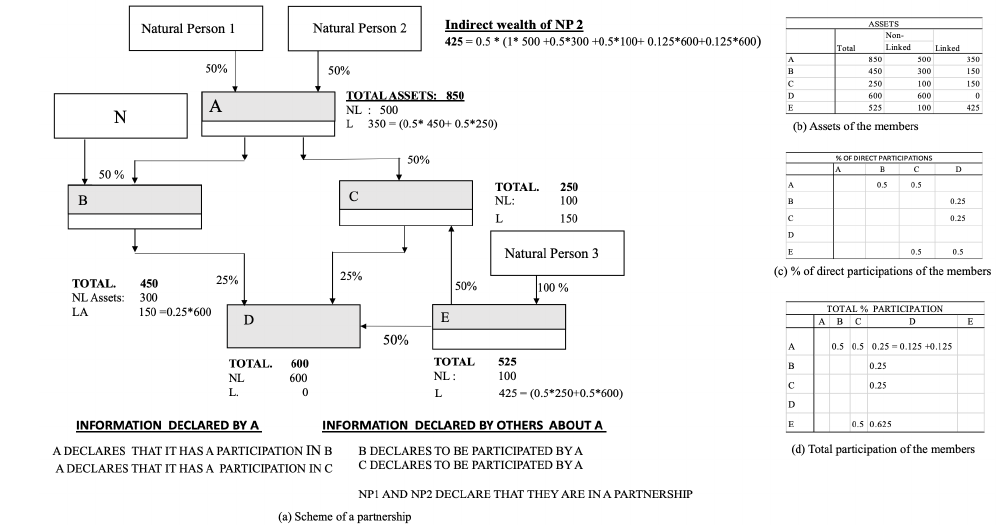
Figure 1. Example of calculation of indirect